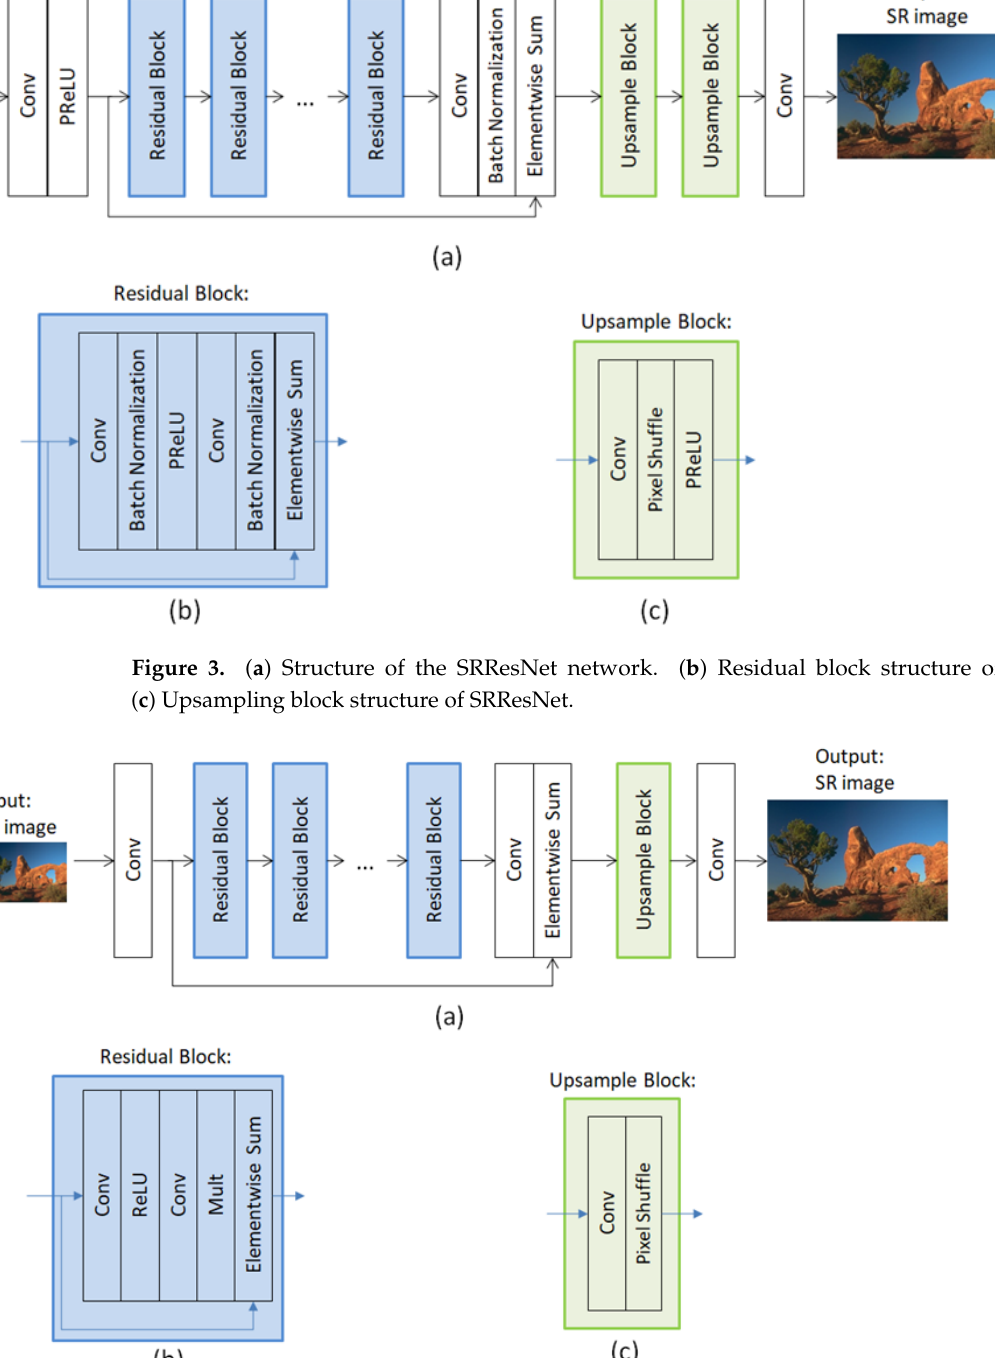
Figure 3. ( a ) Structure of the SRResNet network. ( b ) Residual block structure of SRResNet. ( c ) Up- sampling block structure of